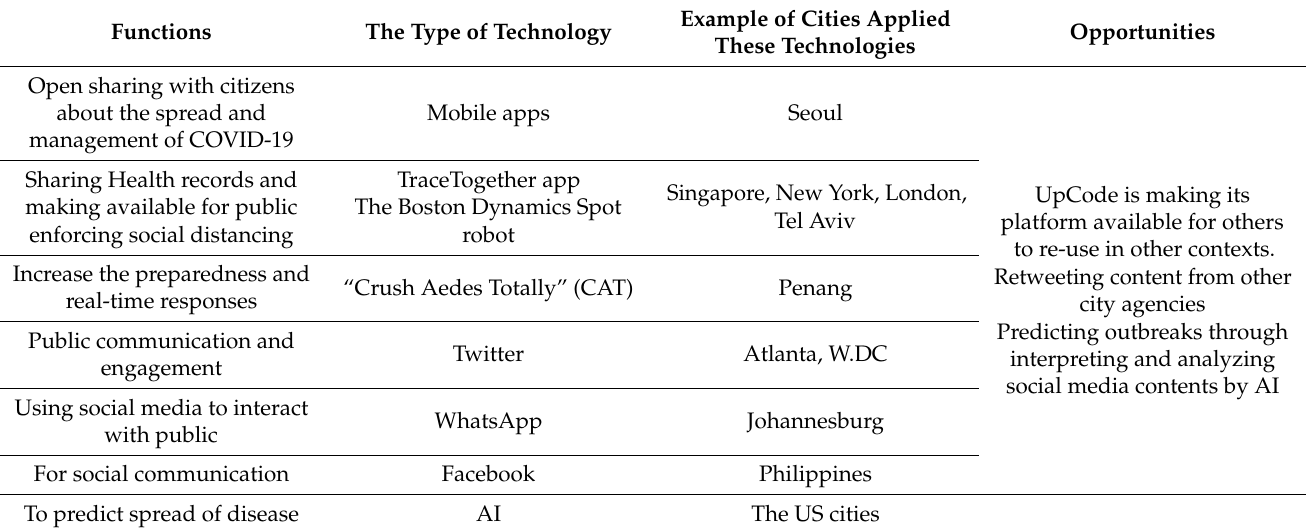
Table 1. Technology deployment and functions to improve participation, transparency and social connectedness during